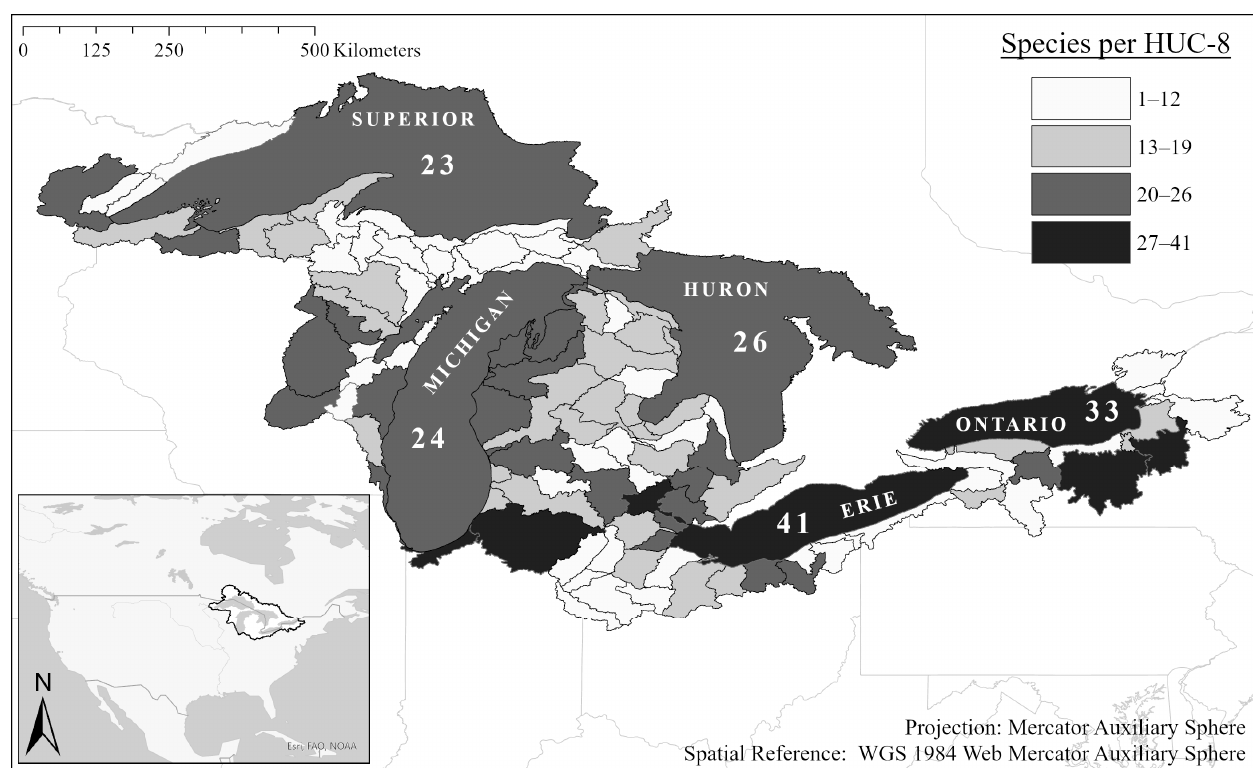
Figure 2. Distribution of aquatic nonindigenous plants in the Great Lakes basin by sub-watershed.